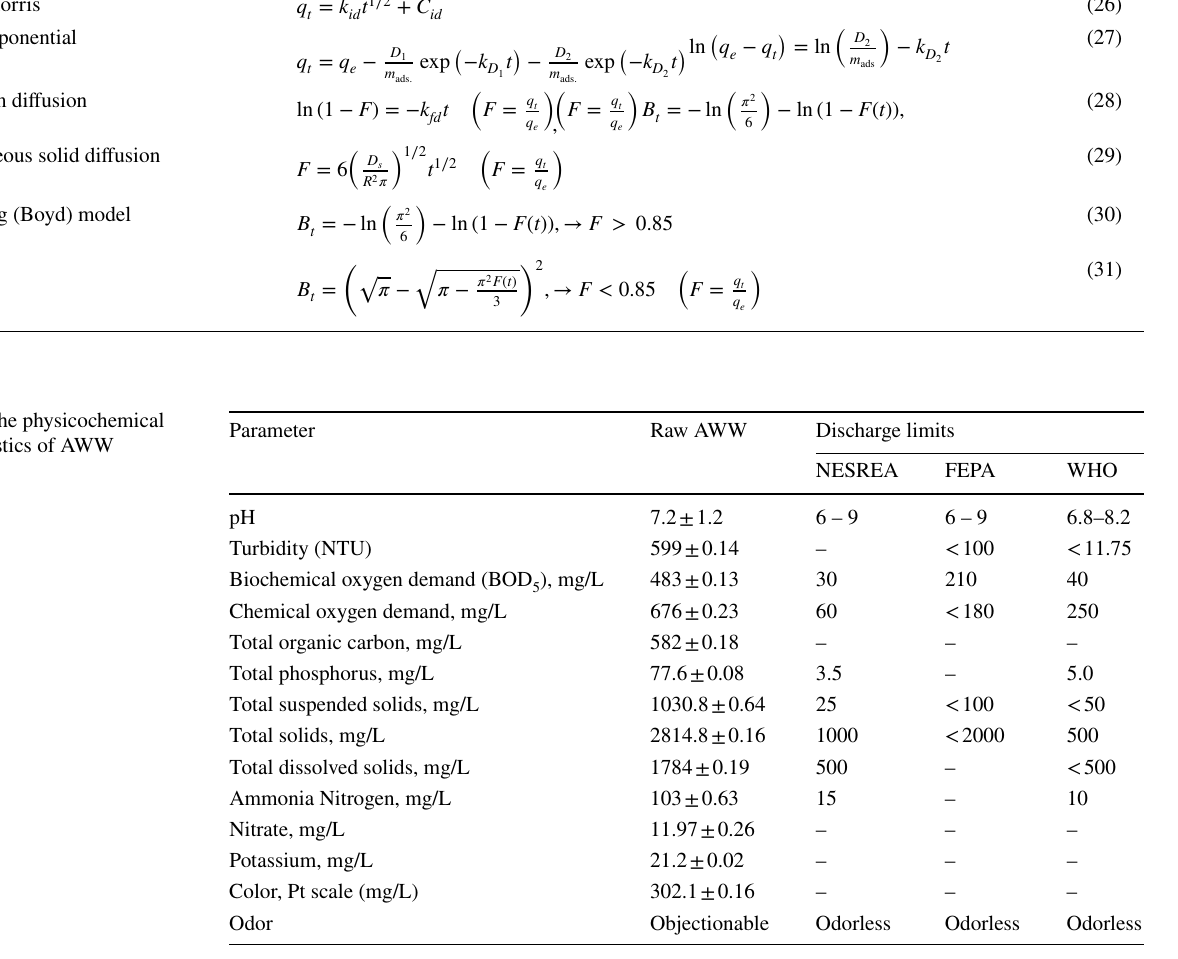
Table 3 The expression of the mechanistic models applied in the study Mechanistic model Mathematical expression Eq. no Webber Morris